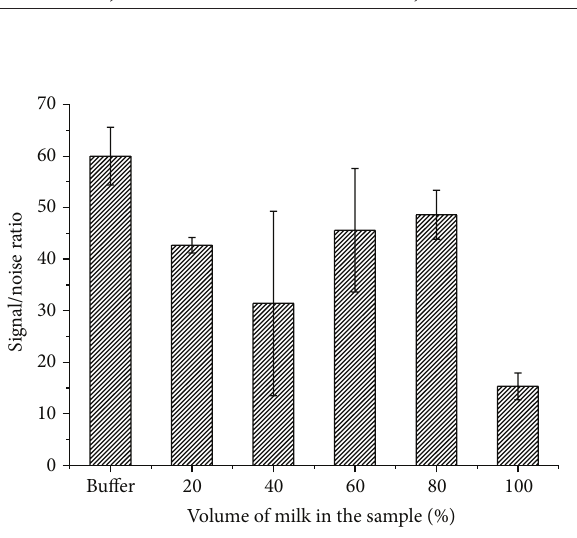
Figure 8: Dependence of the intensity of coloration of the test zone of IC test systems on Tween-20 detergent concentration in the absence of TC.